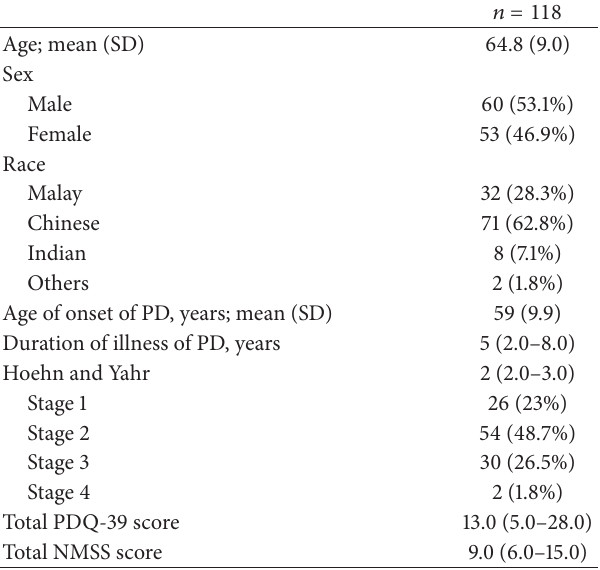
Table 1: Baseline characteristics of study population.